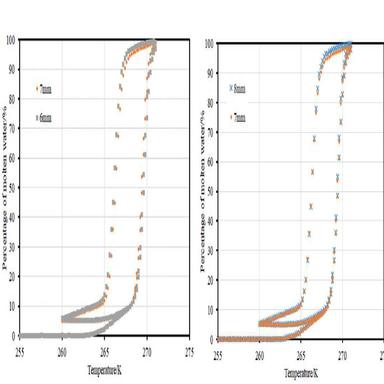
Pairwise comparisons (a–f) of cryoporometry melting and freezing curves for internal (i.e. non-end) MRI slices of extrudate, each indicated by the distance of the proximal edge from one end of the extrudate, as shown in